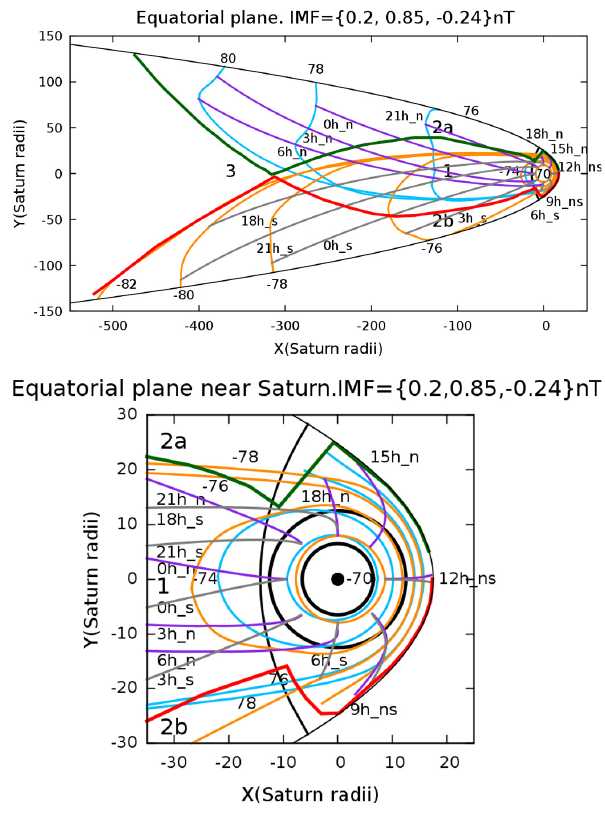
Fig. 1. Projections of polar regions into Saturn’s equatorial plane for conditions corresponding to HST image A of Belenkaya et al. (2011), in which the KSM IMF vector has ( X , Y , Z ) compo- nents of (0.20, − 0.85, − 0.24)nT. Panel (a) shows an extended view, while panel (b) shows a view of the nearer-planet region. The green and red lines mark the boundary between open and closed field lines mapped from the north and south polar regions, respectively. Re- gion “1” between the red and green lines for x > − 312 R S thus corresponds to the region of closed field lines, while region “3” between these lines for x < − 312 R S contains interplanetary field lines that pass through the tail. Regions “2a” and “2b” correspond to open field lines mapping to the northern and southern polar caps, respectively. Projections of constant latitude circles from the north and south are shown by the blue and orange lines, respectively, marked with the corresponding latitudes at 2 ◦ intervals. Purple and grey curves show corresponding northern and southern lines of con- stant MLT at 3h intervals, as marked, where “n” and “s” correspond to “north” and “south” respectively.